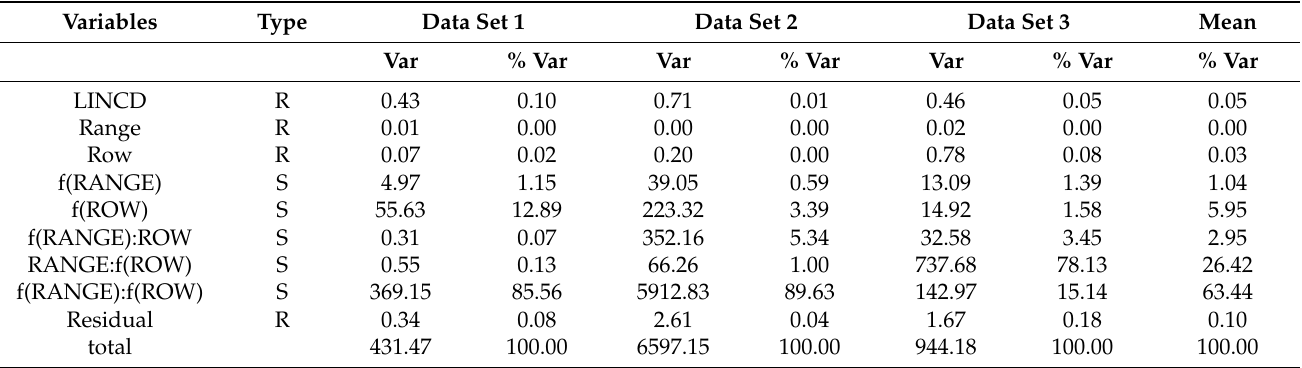
Table 5. Summary of variance component analysis from the tensor product penalized P-splines. Var stands for variance, and type for data type; “R” for random and “S” for surface variable.